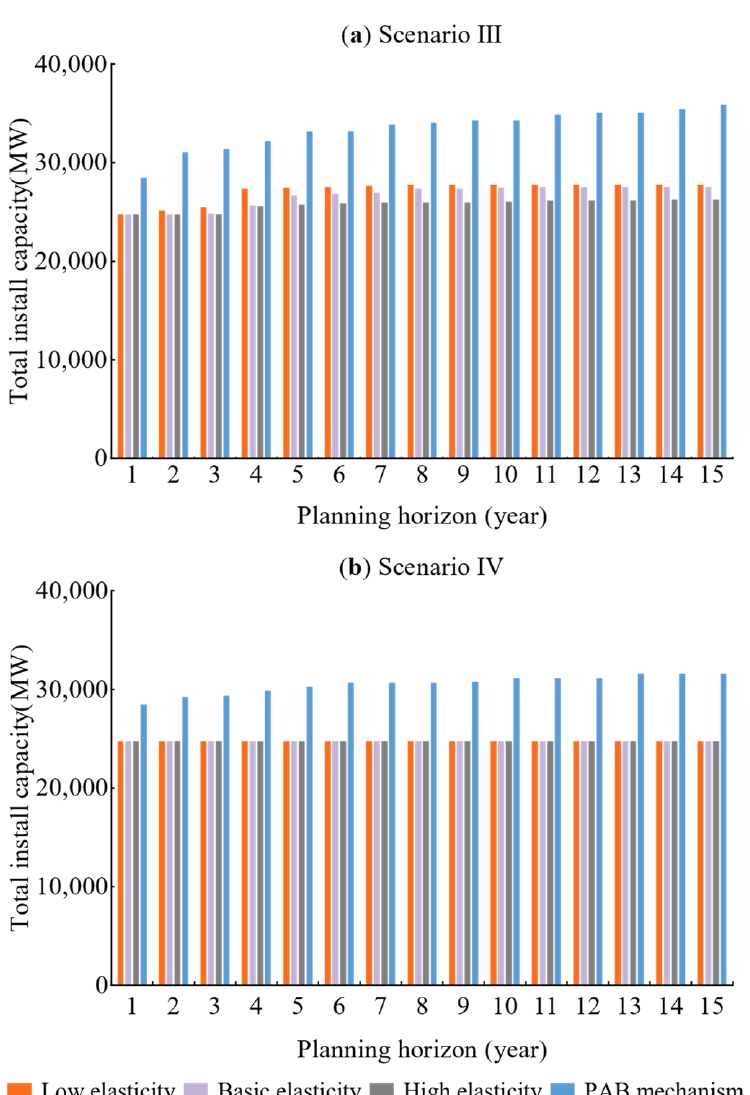
Figure 6. Evolution results of installed capacity of PAB mechanism and supply–demand adjustment mechanism in Scenario III and Scenario